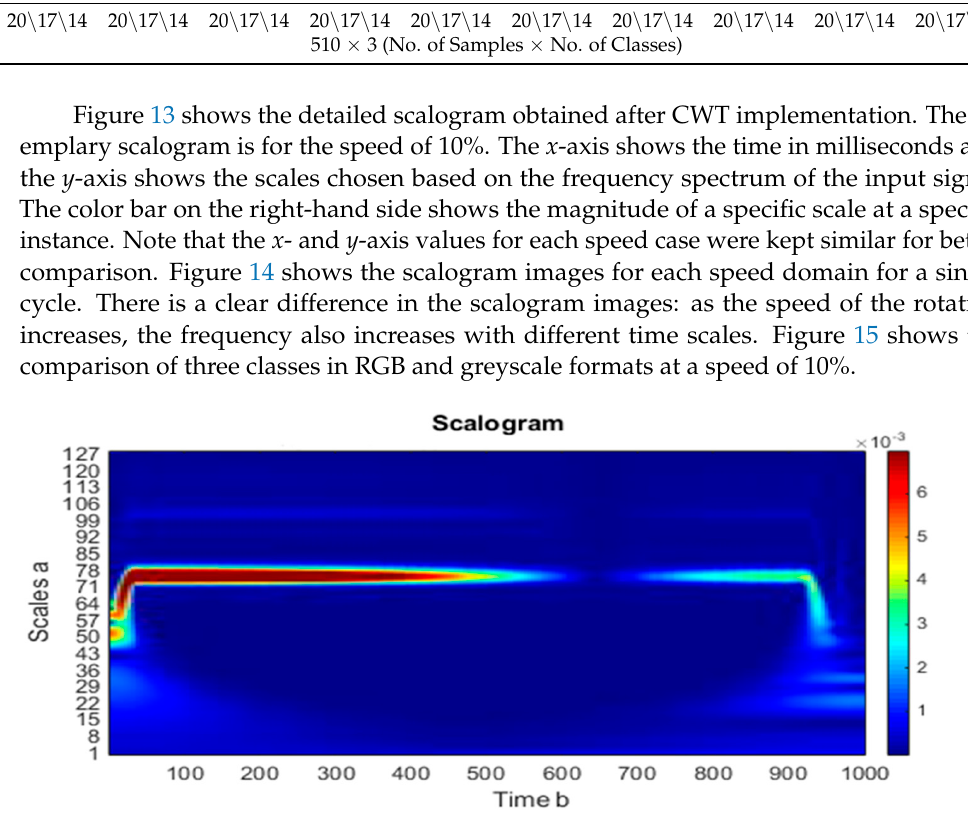
Figure 13. Example of a scalogram obtained after CWT implementation for the speed of 10%.